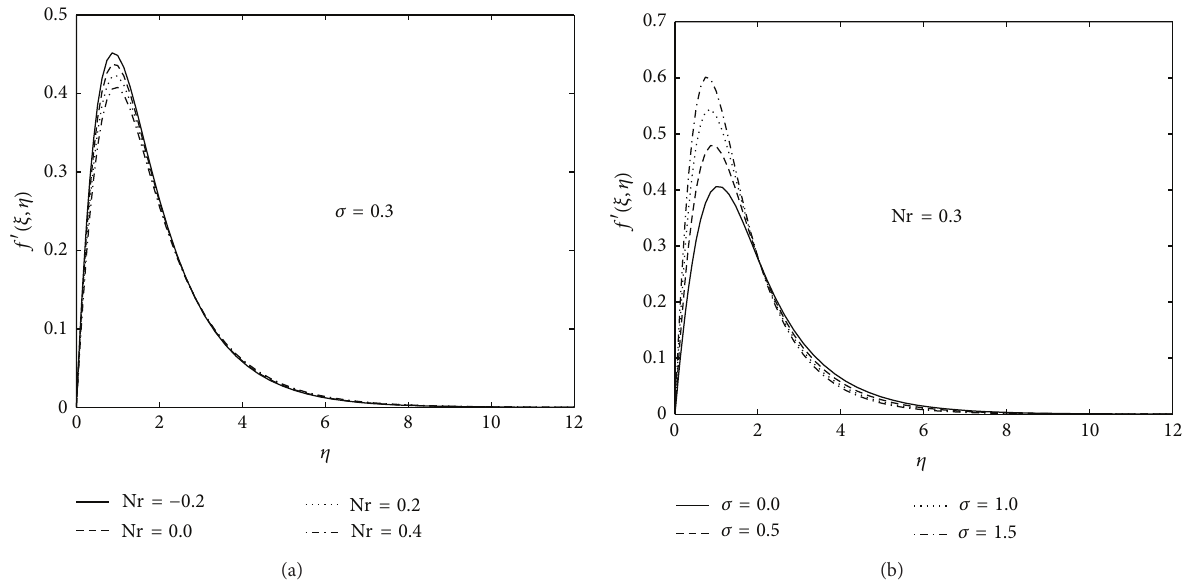
Figure 1: Effect of the buoyancy ratio Nr on 𝑓(𝜂) and 𝑓 󸀠 (𝜂) for 𝜉 = 0.5 , Le = 10 , Pr = 7 , Nt = 0.1 , Nb = 0.5 , and 𝐴 = 0.1 .